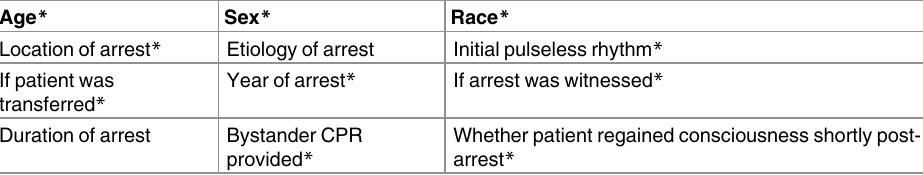
Table 1. Variables explored for registry risk